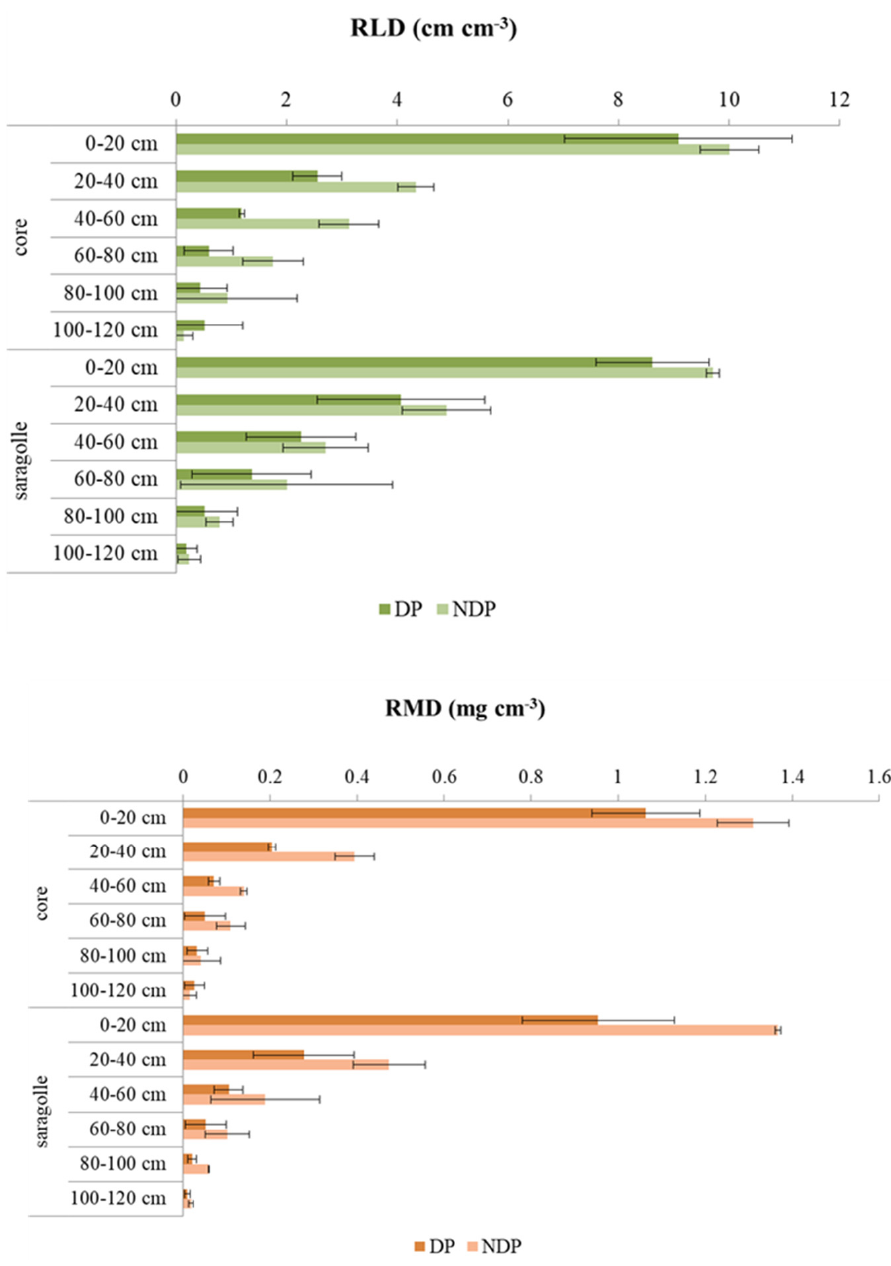
Figure 7. Root length density (RLD) ( top ) and root mass density (RMD) ( bottom ) in Core and Saragolle varieties under dual-purpose (DP) and conventional management (NDP) of six soil layers from surface soil to 1.20 m. Means are overlaid by standard deviation bars.